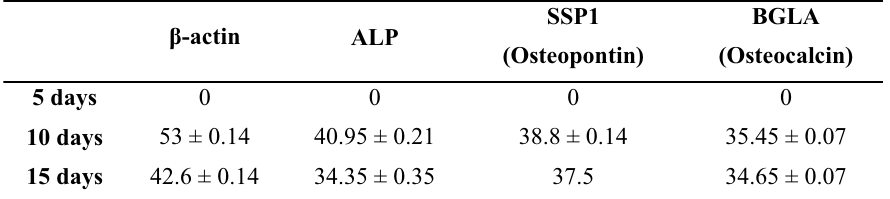
TABLE 1 - C values for the expression of the ß-actin, BGLA, SSP1, and ALP genes at T different periods of culture